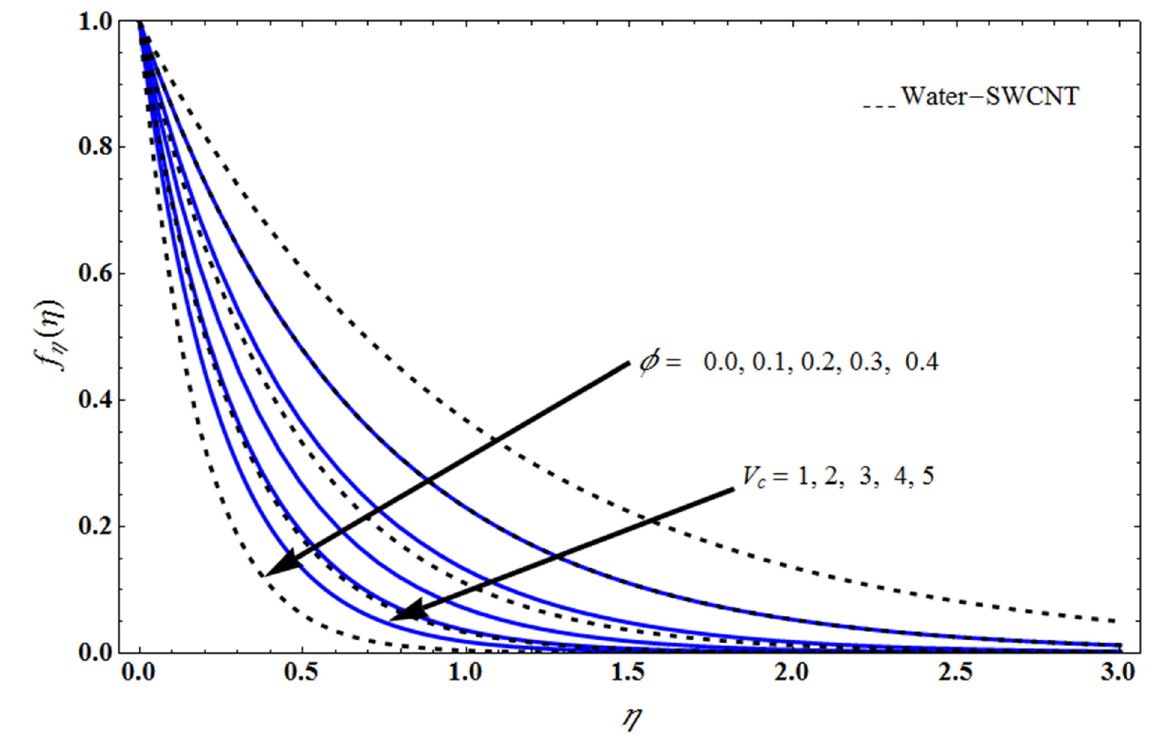
( ) η η f on for various values of c η